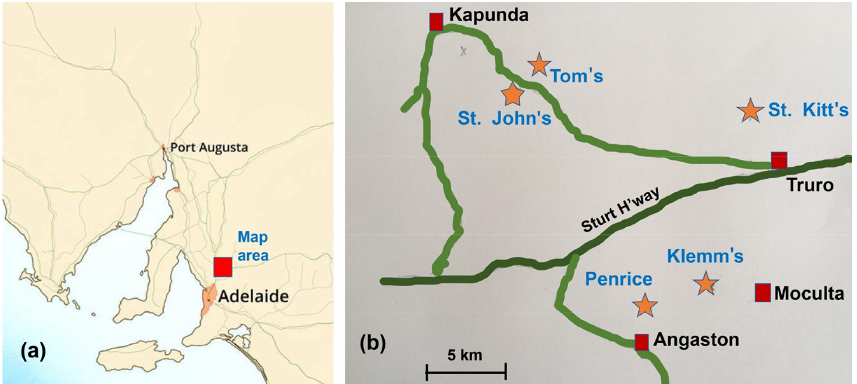
Figure 1. (a) Location of the Kapunda–Angaston phosphate province in a map of South Australia. (b) Phosphate deposits in the Kapunda– Angaston